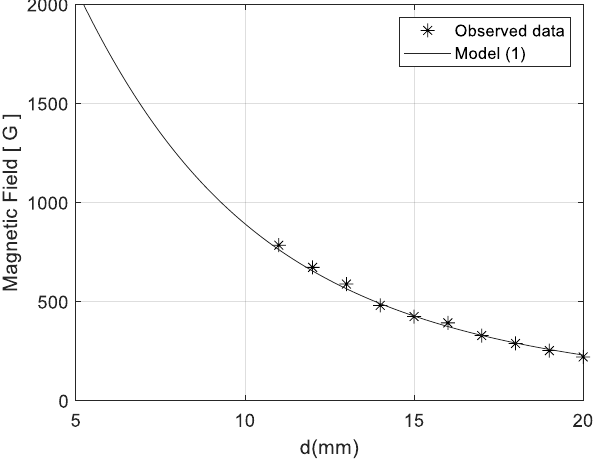
Figure 2. Measured and estimated magnetic field intensity as a function of the distance, d, from the permanent magnet.